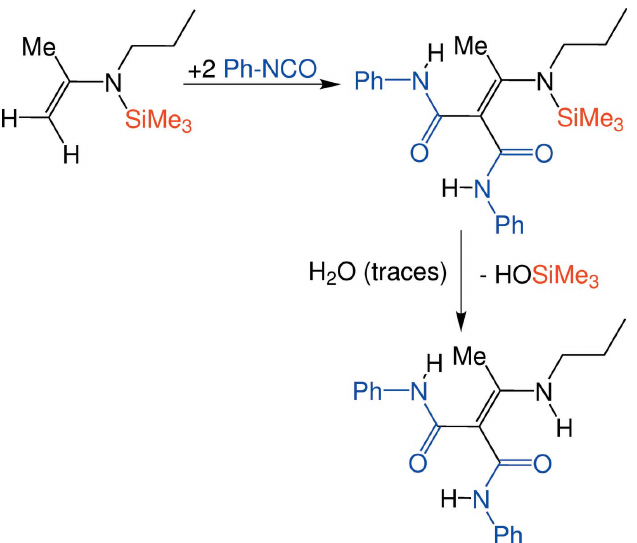
Figure 6 Reaction scheme for the synthesis of the title compounds.